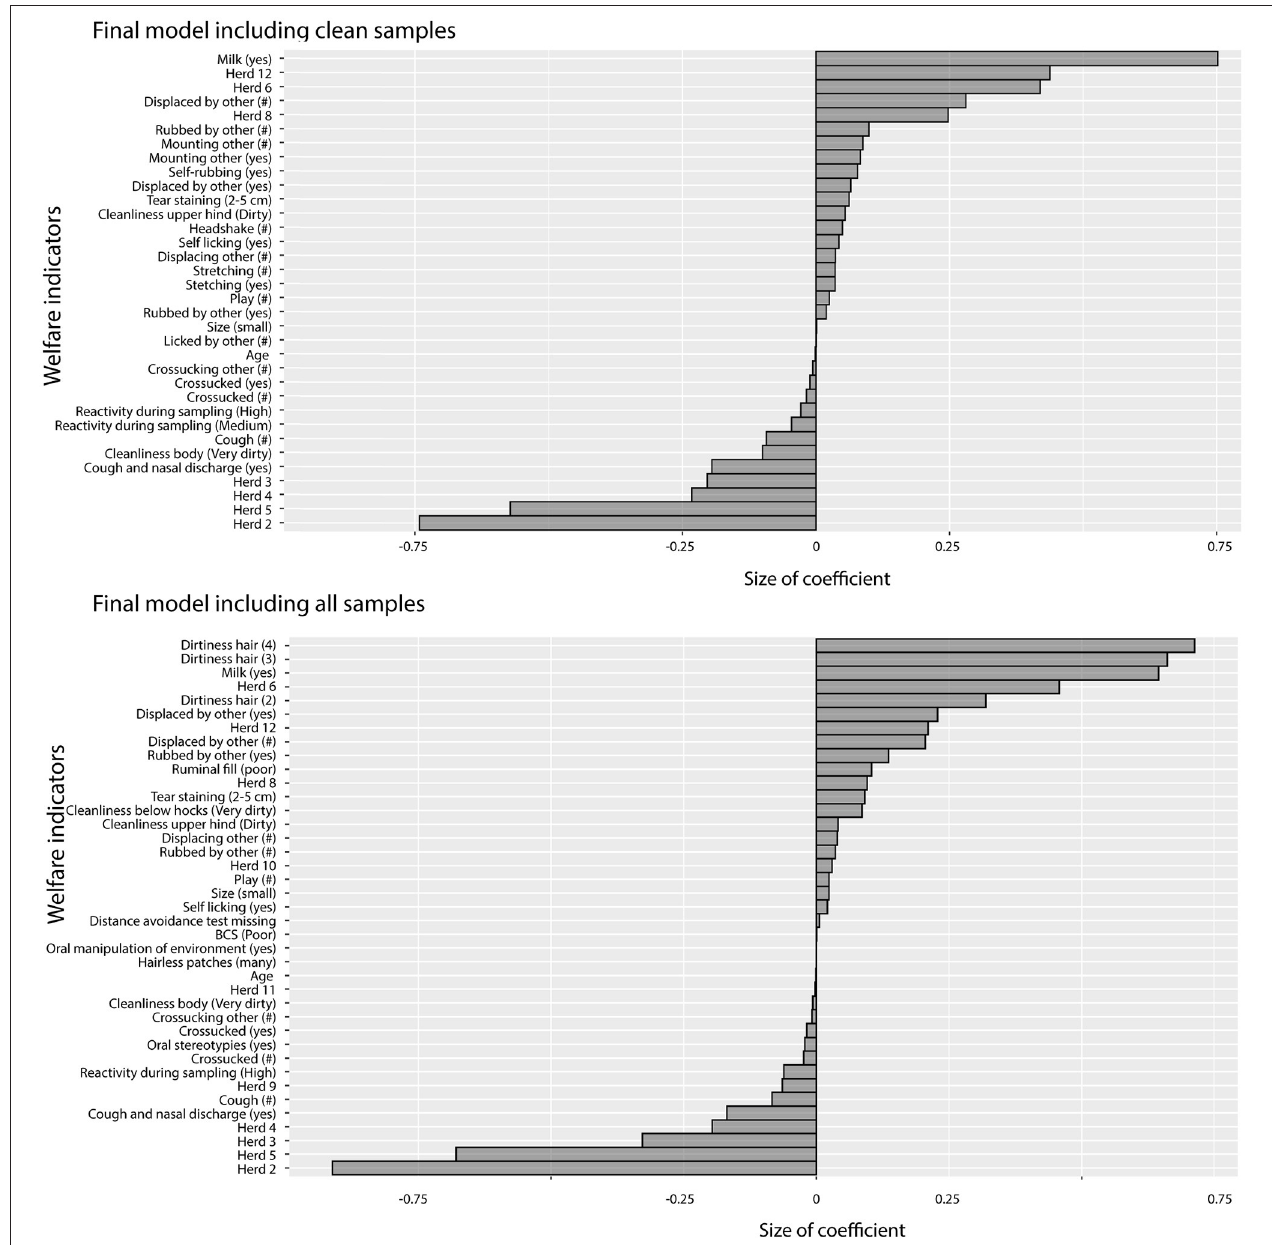
FIGURE 2 | Coefficients from the regularized regression model that minimized root mean squared error. Positive coefficients were positively associated with HCC and negative coefficients were negatively associated with HCC. Behavioral variables marked with (#) are quantitative measures of the number of times the behavior was observed as opposed to binary variables indicating whether a behavior was observed